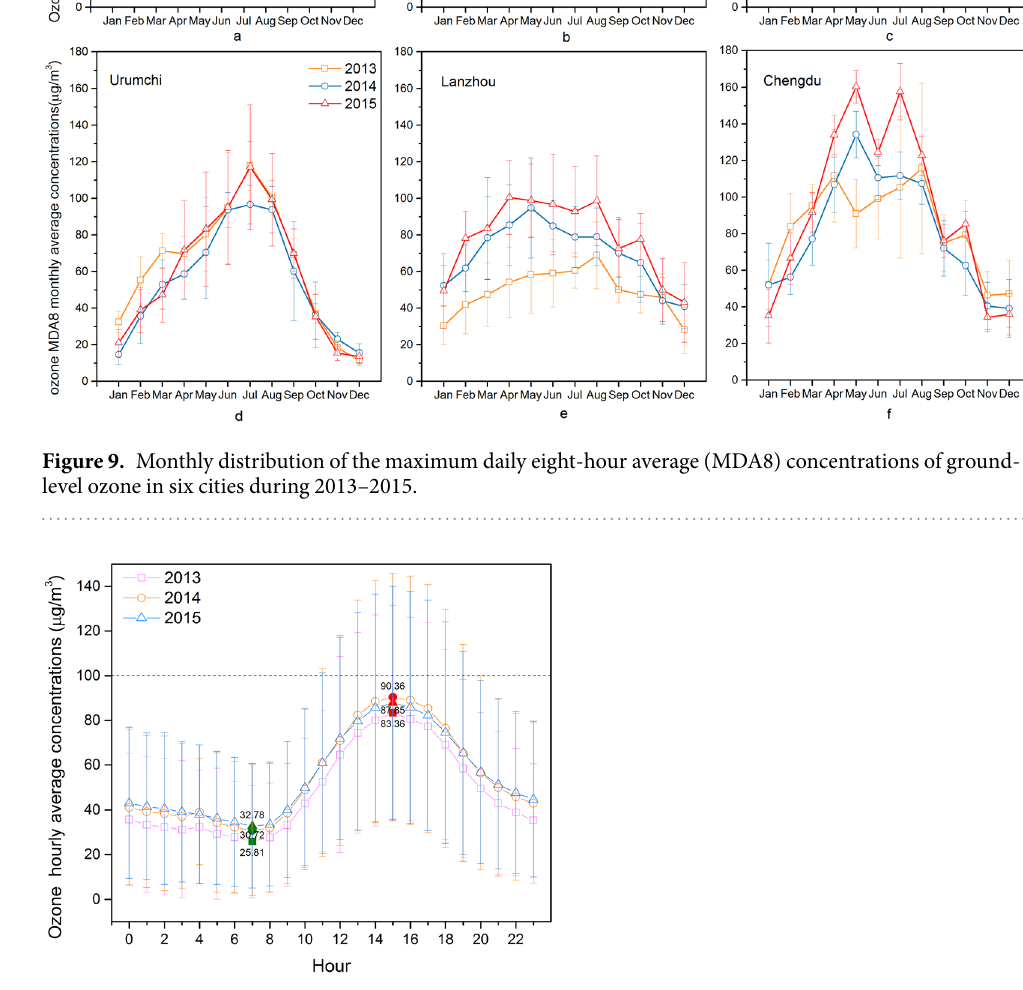
Figure 10. Hourly distribution of the maximum daily eight-hour average (MDA8) concentrations of ground- level ozone in densely populated regions during